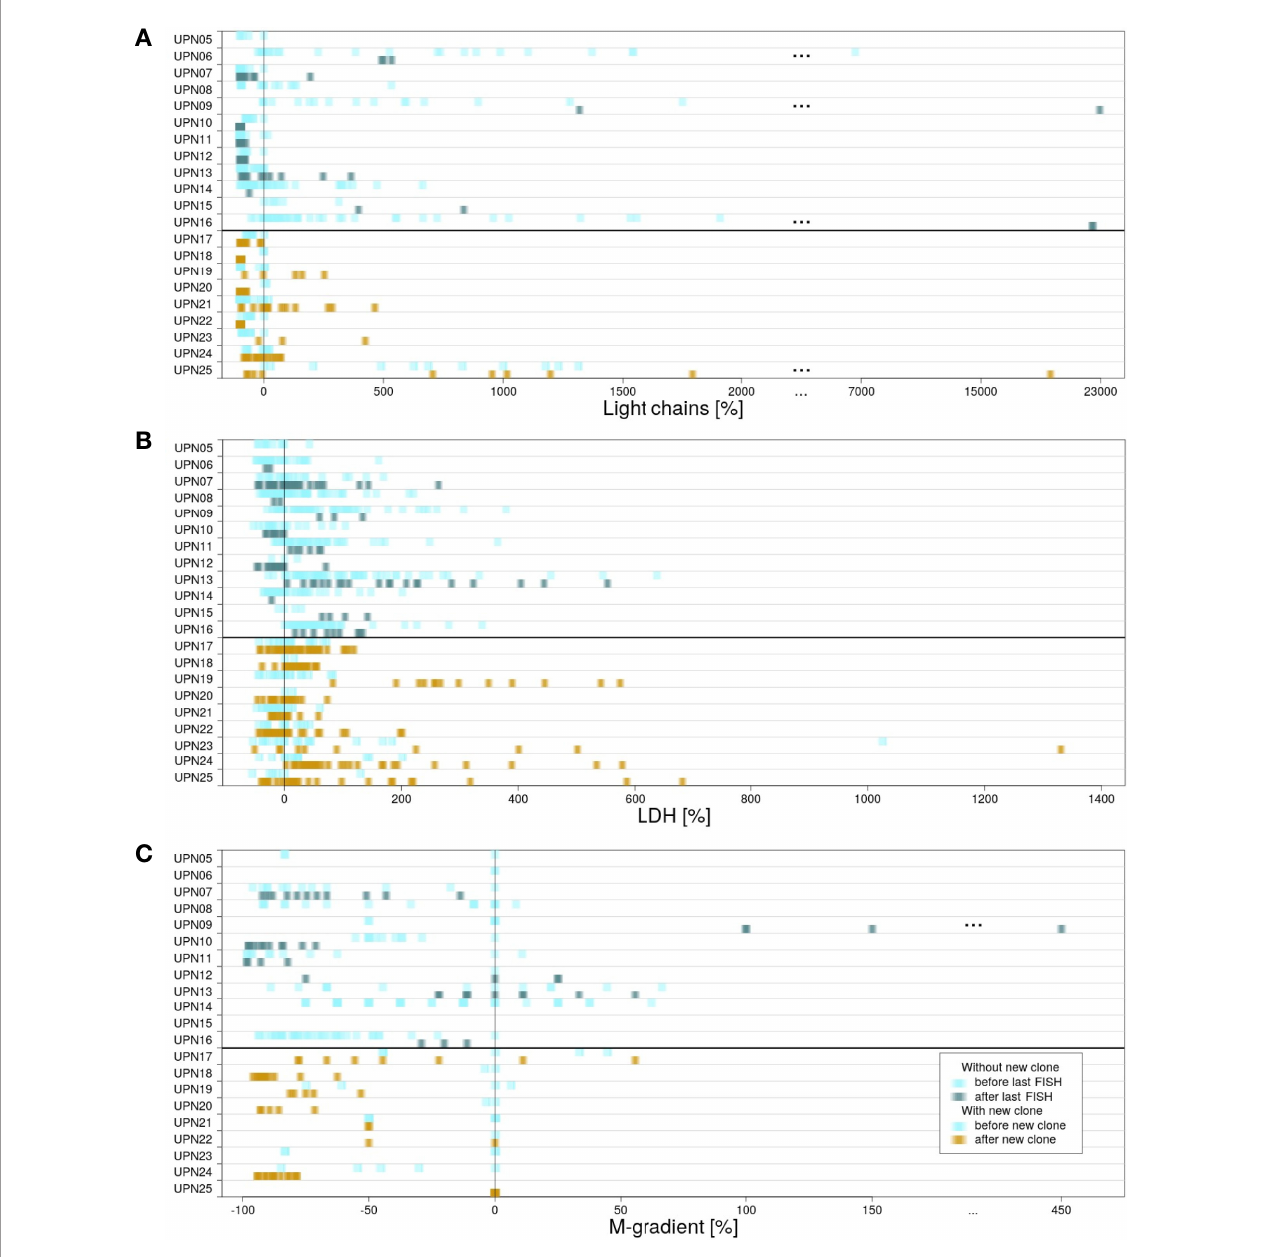
FIGURE 3 | Differences in measured laboratory parameters. For patients in subgroup 1, laboratory parameters measured before (light blue) and after (blue/green) last FISH. For patients in subgroup 2, laboratory parameters measured before (light blue) and after (yellow) detection of the new clone. (A) k and l light chains measured in serum. (B) LDH activity. (C) Gradient of monoclonal protein